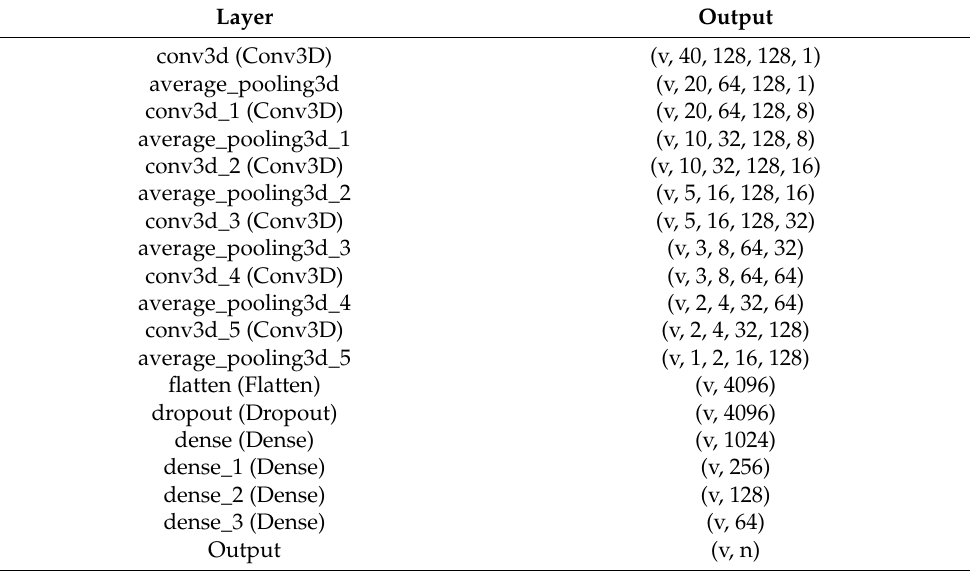
Table 2. ALT-CNN-DENSE Net Architecture Layers